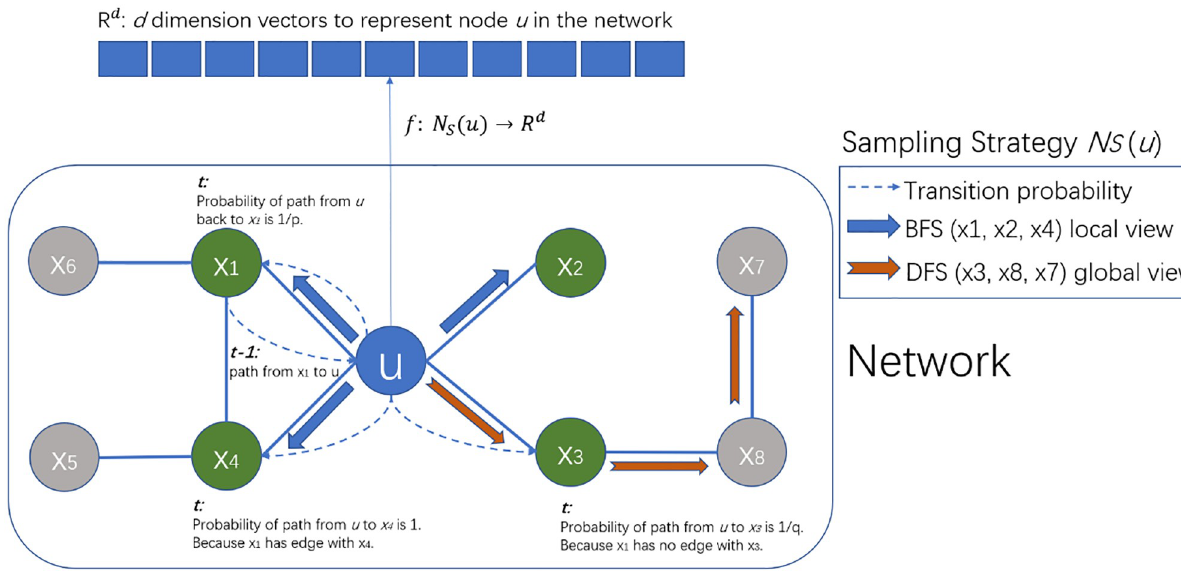
Fig 2. The framework of Node2vec. Developed from Node2vec